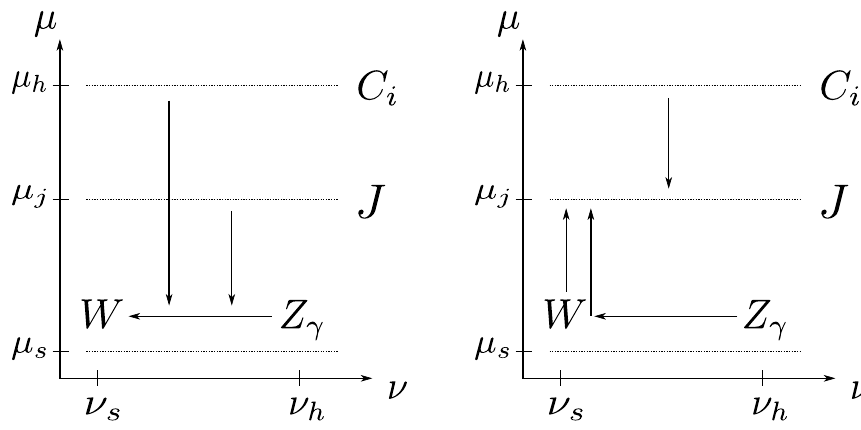
Figure 2 . Di(cid:11)erent possibilities for resumming the functions in the factorization theorem. Left: common reference scale is (cid:22) s . Right: common reference scale is (cid:22) j . In both cases, Z (cid:13) is evolved in (cid:23) from (cid:23) h to (cid:23) s